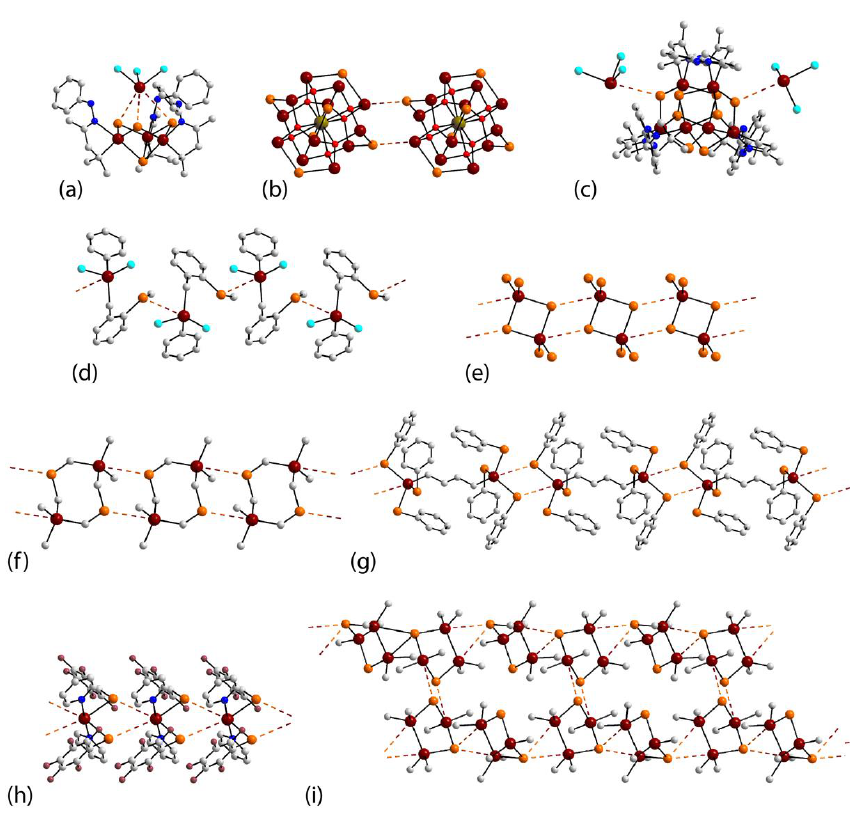
Figure 2. Supramolecular aggregation via Sn … Se secondary bonding in (a) 1 {UJAZIQ; d(Sn … Se) =